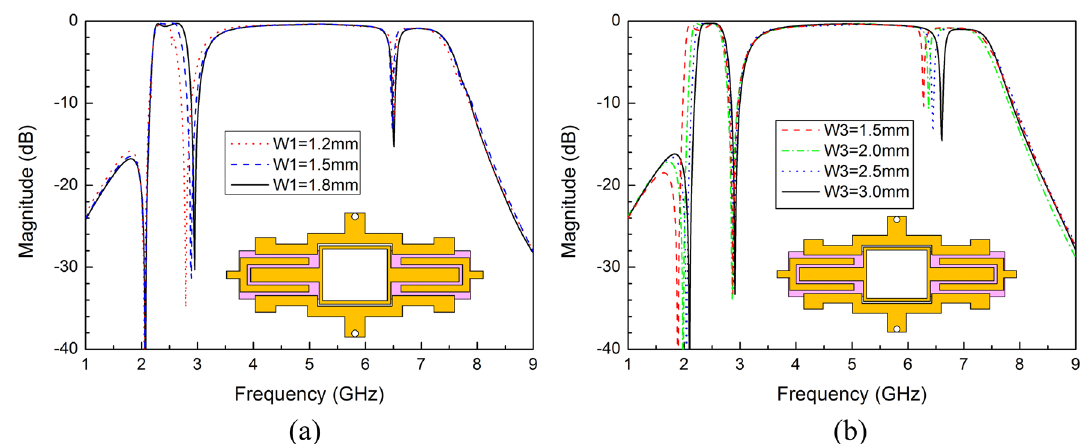
Figure 12. ( a ) The variable first notch frequency corresponding to different width W1. ( b ) The variable third notch frequency corresponding to different width